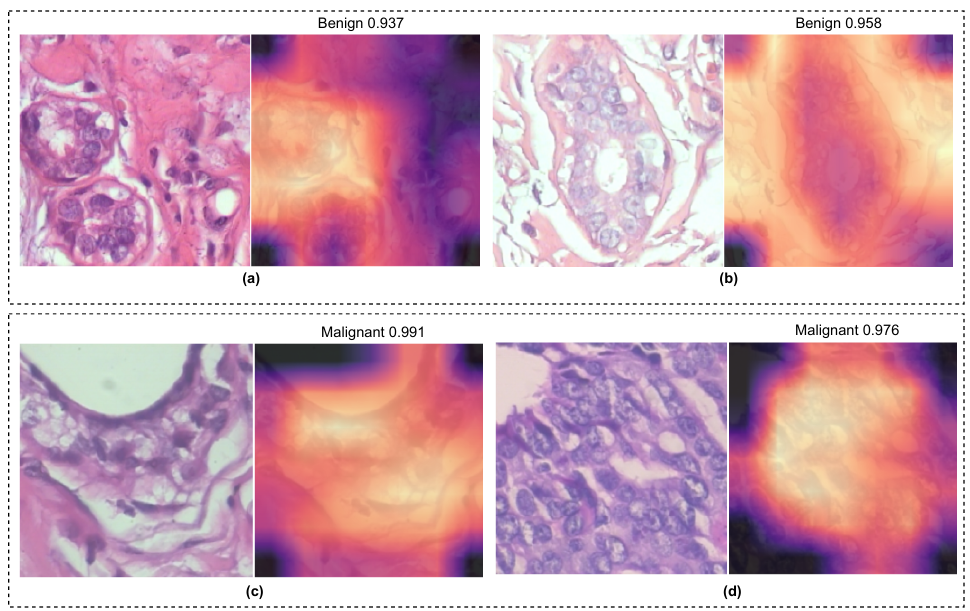
Figure 9. GradCam visualisation of the proposed model for H & E -stained breast tumour patch examples of benign ( a , b ) and malignant ( c , d )